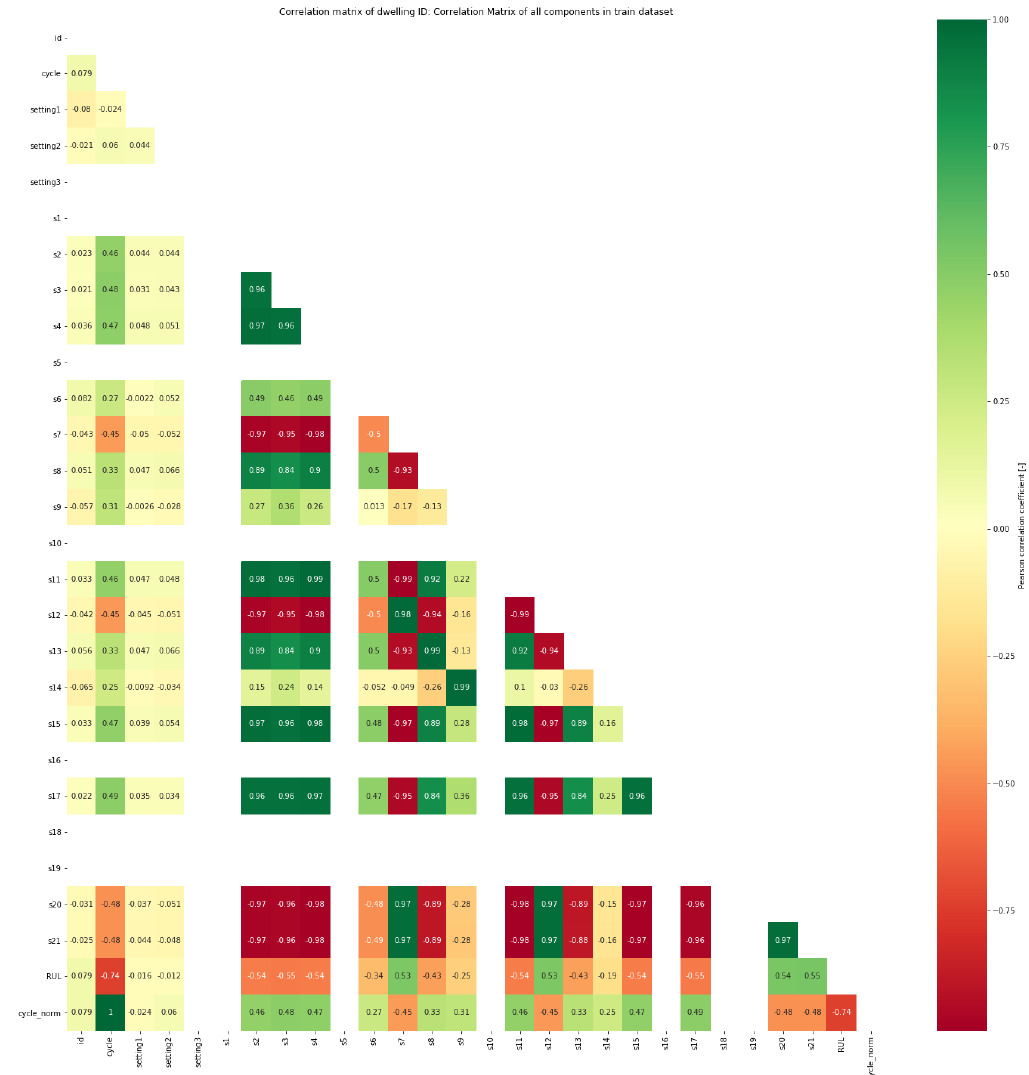
Figure 2. Correlation matrix heat map of the Commercial Modular Aero-Propulsion System Simulation (C-MAPSS) dataset.